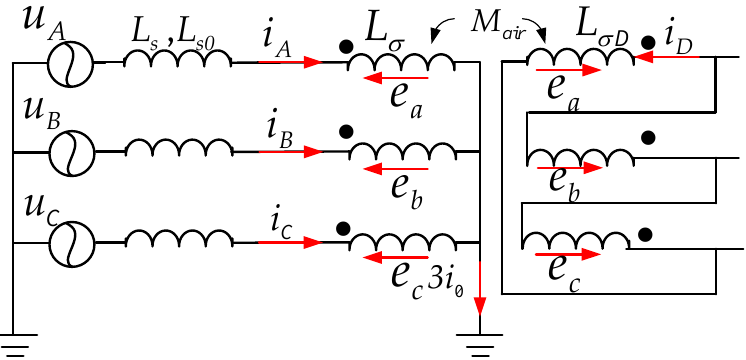
Figure 2. Y 0 / ∆ three-phase transformer magnetizing inrush current equivalent